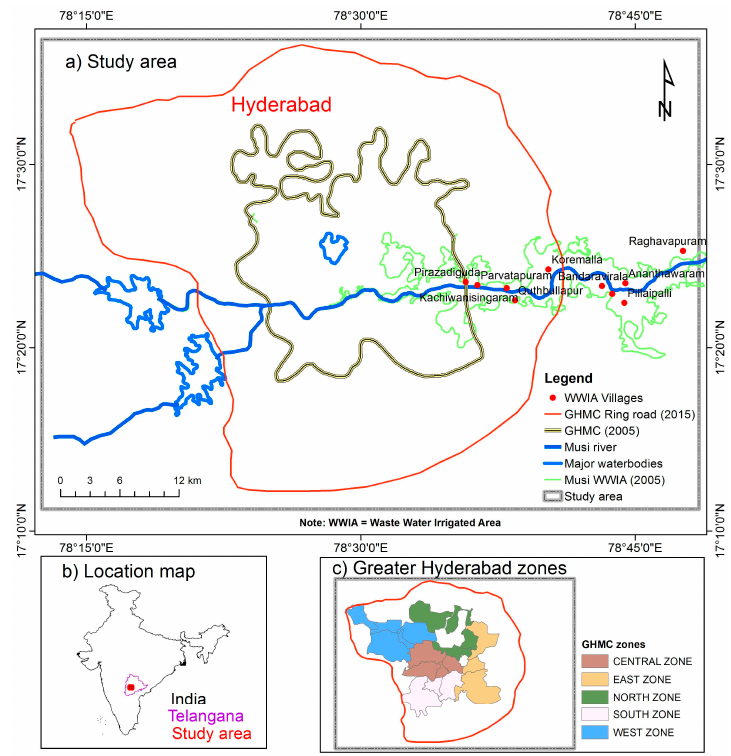
Figure 1. Maps of the study area showing different features: ( a ) Greater Hyderabad Municipal Corporation (GHMC); ( b ) location of study area and ( c ) different zones in GHMC.